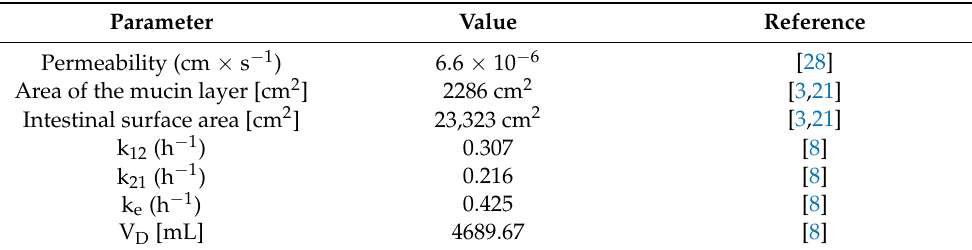
Table 5. Modeling parameters used for the simulation of human